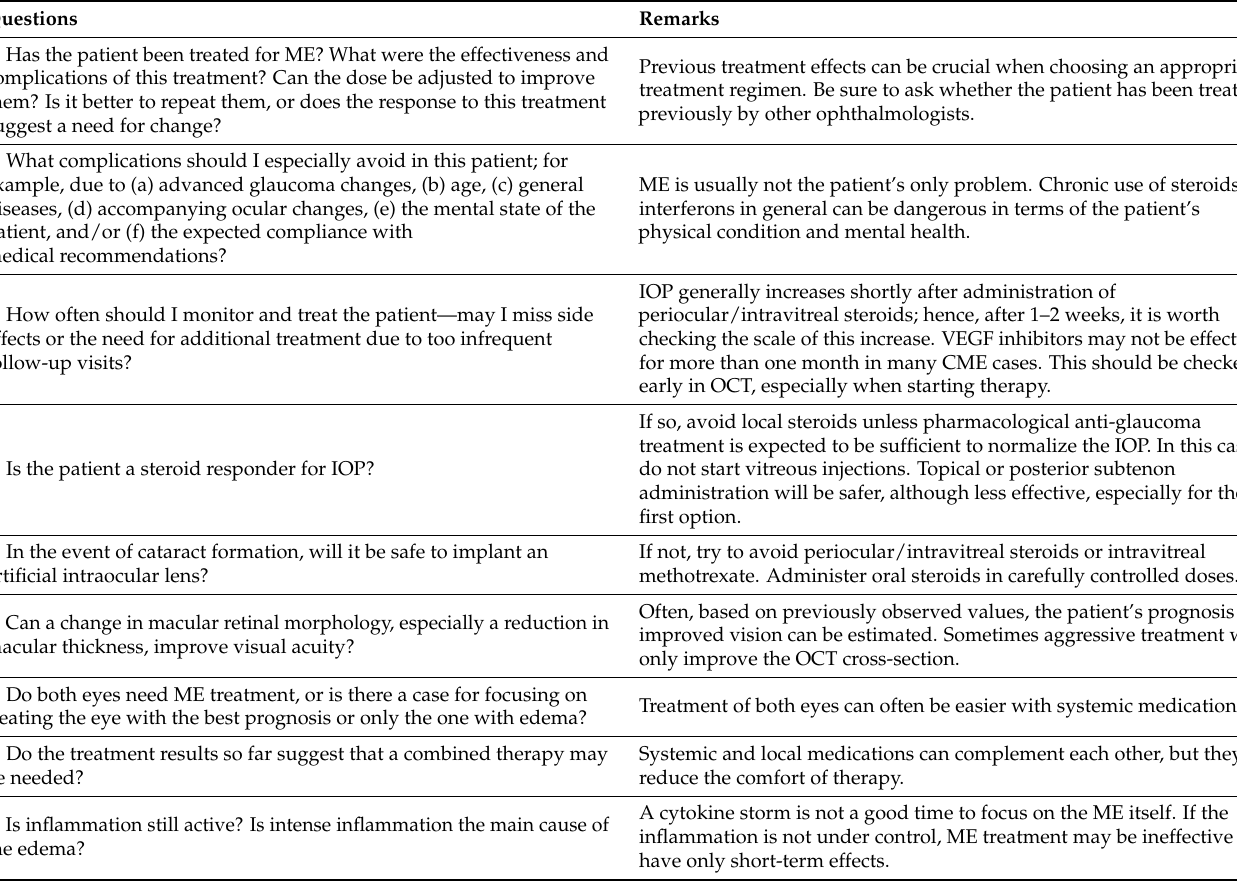
Table 2. Questions facilitating the choice of treatment of uveitic